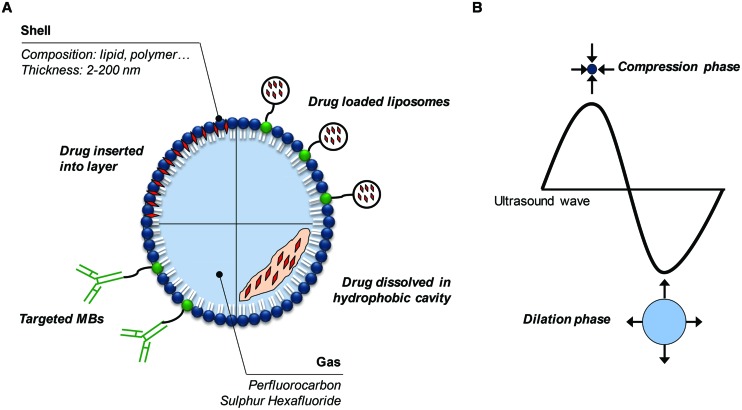
Microbubbles and ultrasound. (A) Different options for drug-loading or targeting of microbubbles. (B) Microbubble oscillations under ultrasound exposure.